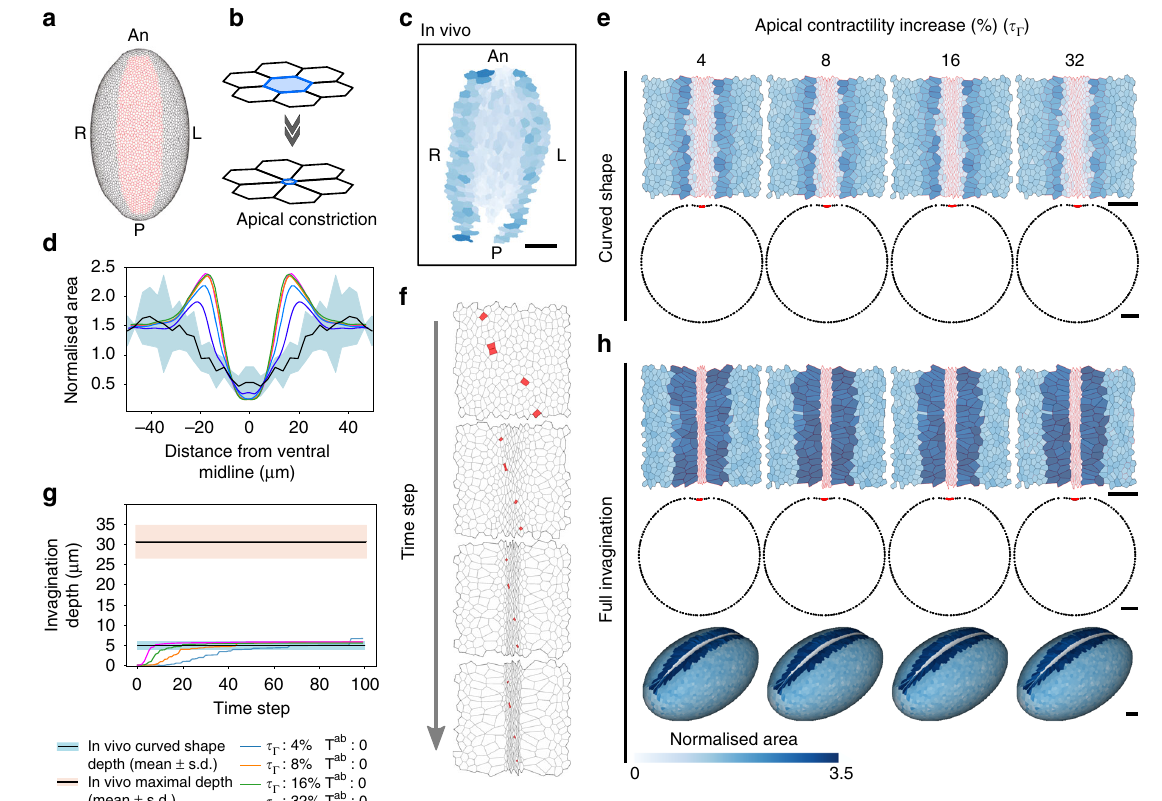
Fig. 7 Apical constriction is not suf fi cient to obtain a fold in a 3D biophysical model. a Ventral view of the virtual embryo before invagination. Ectodermal cell edges are in black and mesodermal cells in red. An: anterior, P: posterior, L: left, R: right. b Scheme of the apical constriction process. The cell constricts its apex (blue) until its surface area falls under a critical threshold. c Central region of the curved-shaped mesoderm in vivo. Apical area is color-coded (see color bar below h ). d Comparison of cell area in the curved-shaped mesoderm in vivo and in the model. Graphs show the normalized cell area in vivo (mean: black line, s.d.: blue band, n = 3 embryos) and in simulations for different values of apical contractility increase τ Γ (color-coded as indicated in g ) with respect to the distance from the ventral midline. e Top row: Images show the central region of the curved-shaped mesoderm in simulated embryos for different values of apical contractility increase τ Γ . Apical area is color-coded and cell edges are red in the mesoderm and black elsewhere. Bottom row: Tissue deformation (sagittal views) of the simulation results of curved-shaped embryos. For each simulation, the curved shape was de fi ned as the time step when the invagination depth corresponds to the in vivo depth when the embryo adopts a curved shape. Scale bar: 25 µ m. f Time-lapse images of the ventral part during mesoderm invagination showing apical extrusion of a few cells (marked in red). g Invagination depth as a function of time for different values of apical contractility increase τ Γ (color-coded as indicated below). The black lines with a blue (resp. pink) border denote the average depth measured in vivo when the embryo adopts a curved (resp. at the end of invagination). h Same as ( e ) at full invagination stage for upper and middle rows. Bottom row: Tissue deformation (3D view) of the simulation results at full invagination stage. Scale bar: 25 µ m. No apico-basal force was exerted in the above simulations ( T ab =